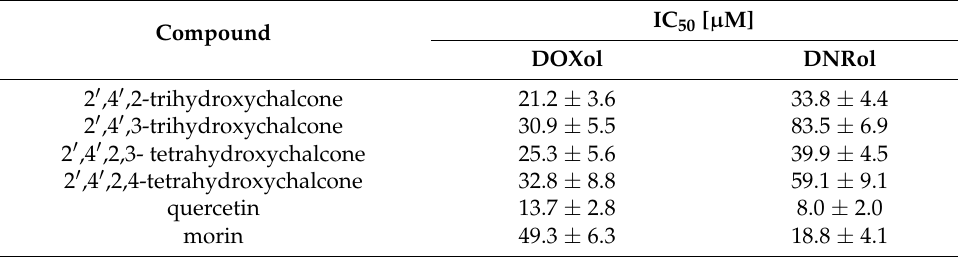
Table 12. Chalcone concentrations inhibiting by 50% (IC50) the formation of doxorubicinol (DOXol) and daunorubicinol (DNRol) in hearts of DOX- or DNR-treated rabbits [26]. IC 50 [ µ M] Compound DOXol DNRol 2 (cid:48) ,4 (cid:48)